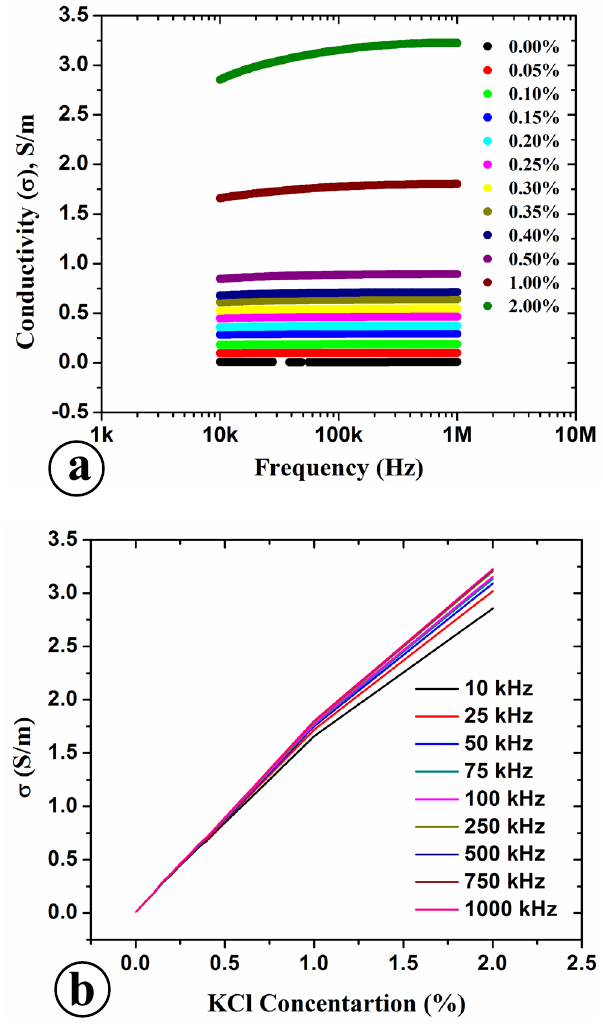
Figure-4: Conductivity profile of KCl solution (a) variation (over frequency) at different concentration, (b) variation (over concentration) at different